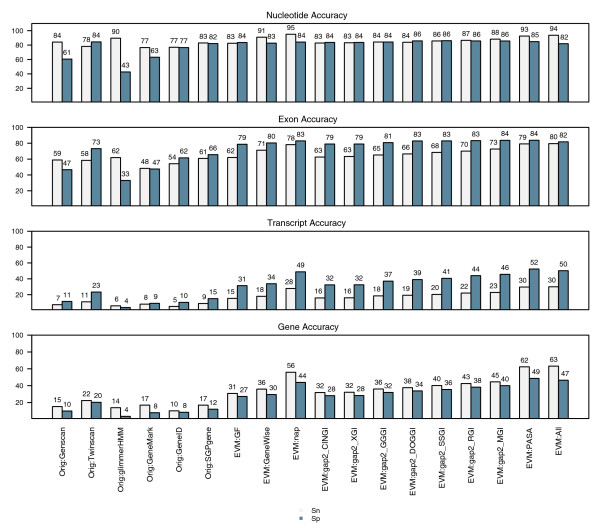
Human consensus gene prediction accuracy by EVM. The consensus gene prediction accuracy by EVidenceModeler (EVM) is shown based on trained evidence weights and the corresponding combination of evidence, as applied to the GENCODE test regions of the human genome. The accuracies for the inputted gene predictions obtained from the ENCODE Genome Annotation Assessment Project (EGASP) dataset are provided for reference sake, including GENSCAN, TWINSCAN, GlimmerHMM, GeneMark.hmm on the repeat-masked genome, GeneID, and SGPgene. EVM-GF corresponds to EVM applied to these gene prediction tiers alone (GF), and serves as the baseline evidence for the subsequent entries. EVM-GeneWise includes GeneWise predictions based on nonhuman protein homologies; EVM-nap includes AAT-nap spliced alignments of nonhuman proteins; the EVM:gap2_* series includes AAT-gap2 alignments of corresponding transcripts from the Dana Farber Gene Indices (CINGI, Ciona intestinalis [sea squirt]; XGI, Xenopus tropicalis [frog]; GGGI, Gallus gallus [chicken]; DOGGI, Canis familiaris [dog]; SSGI, Sus scrofa [pig]; RGI, rat; MGI, mouse); EVM-alignAsm includes Program to Assemble Spliced Alignments (PASA) alignment assemblies and corresponding terminal exon supplement; and EVM:All includes all evidence described (GF, gap2, nap, GeneWise, and PASA). Sn, sensitivity; Sp, specificity.